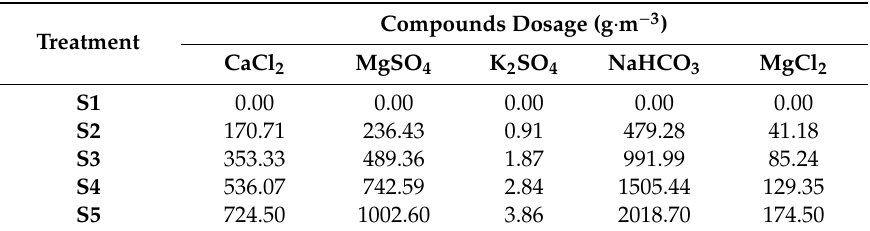
Table 5. Compounds dosage for di ff erent water salinity levels.